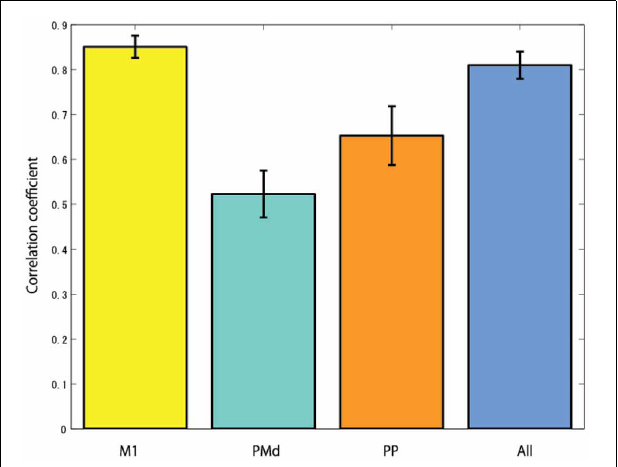
FIGURE 9 | The correlation coefficients when reconstructing EMG signals from the cortical activities estimated in different brain areas (M1, primary motor cortex; PMd, dorsal premotor cortex; PP, posterior parietal cortex; and All, using all brain